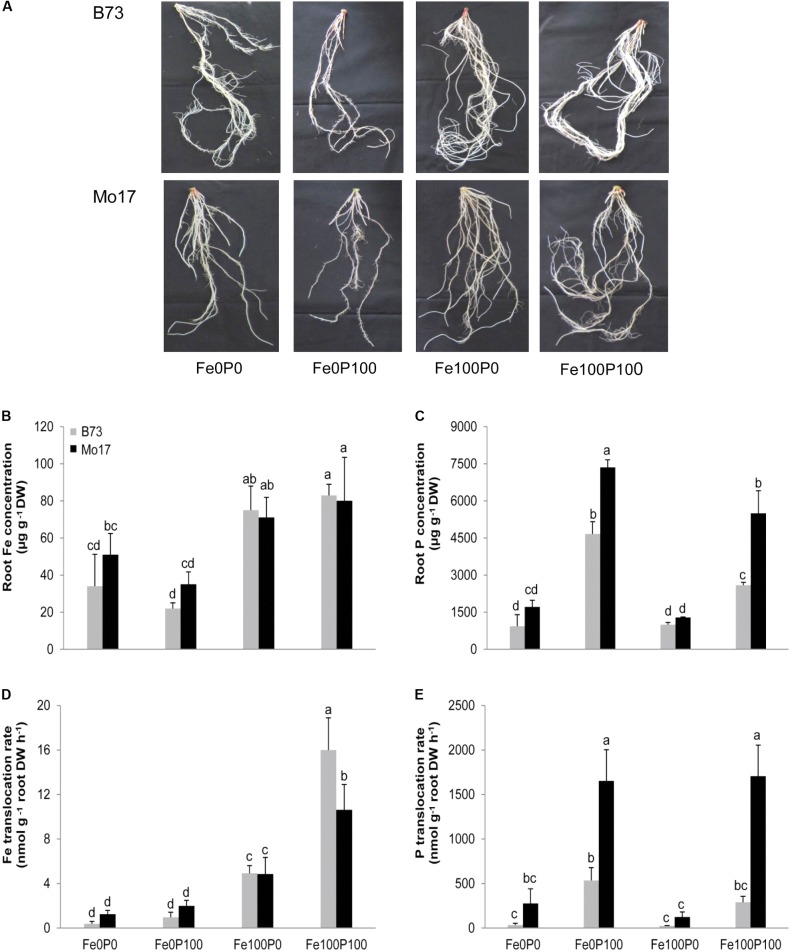
Root growth and physiological root traits as affected by Fe and P nutritional regimes in B73 and Mo17. (A) Root anatomy and root concentrations of (B) Fe, (C) P, or root-to-shoot translocation rates of (D) Fe and (E) P as determined by collecting xylem sap. Plants were grown for 15 days in nutrient solution supplemented without Fe and P (Fe0P0), without Fe and with 100 μM P (Fe0P100), with 100 μM Fe and without P (Fe100P0) or with 100 μM Fe and 100 μM P (Fe100P100). Fe and P treatments were initiated after one week of preculture on full nutrient solution. Bars indicate means ± SD, n = 5. Different letters denote significant differences at p < 0.05.